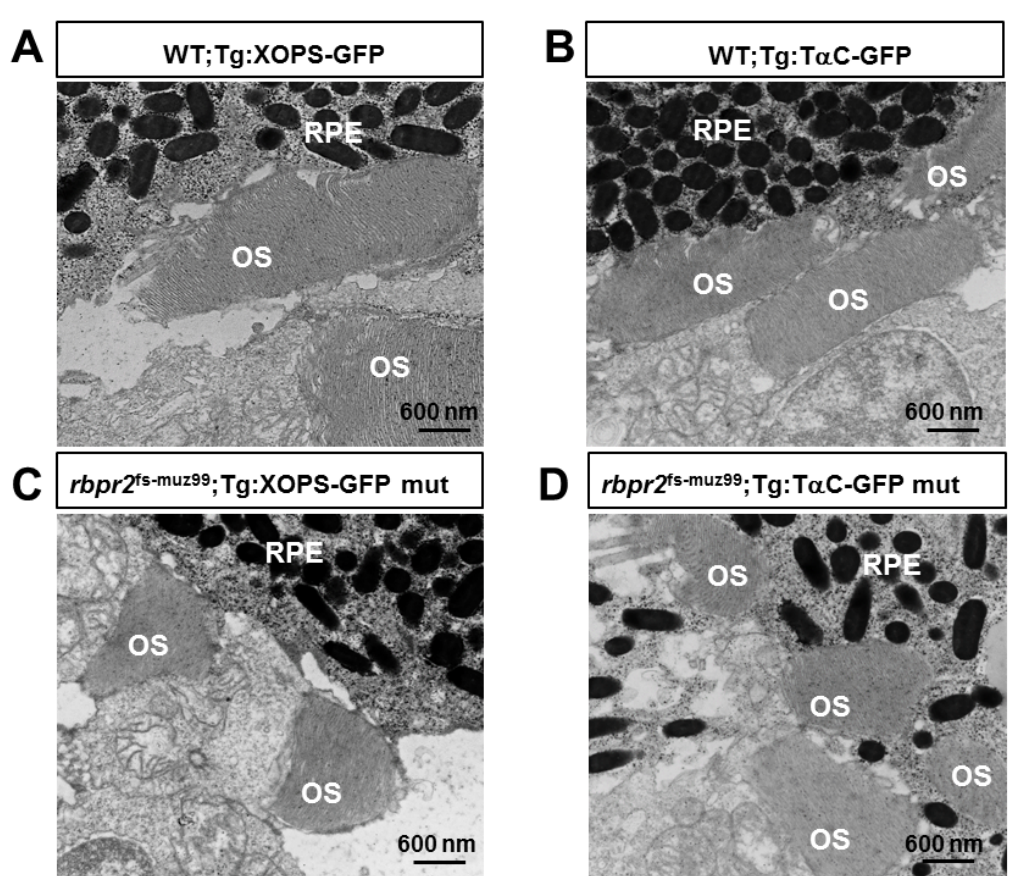
Figure 7. Ultrastructural analysis of rbpr2 fs-muz99 mutant retinas. Transmission electron microscopy provided ultrastructural views of WT-Tg:T α C-GFP and WT-Tg:XOPS-GFP ( A , B ) and rbpr2 fs-muz99 mutant ( C , D ) photoreceptor cells at 5.5 dpf. Scale bar = 600nm. OS, outer segments; RPE, Retinal Pigmented Epithelium. For each genotype, approximately 25–30 zebrafish larvae retinas were analyzed by EM.